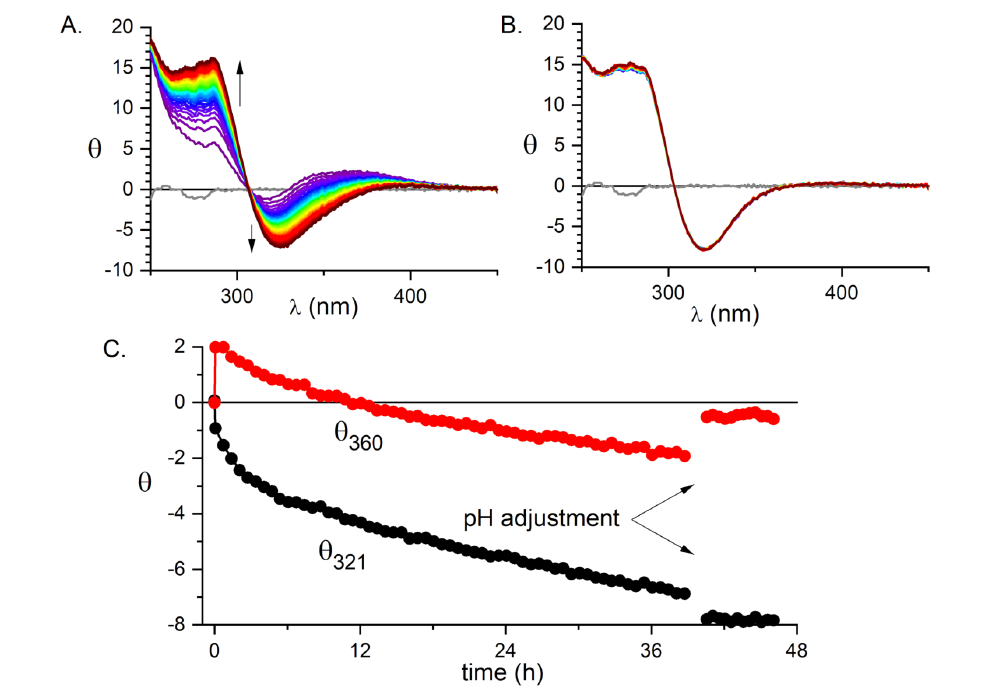
Figure 1. The formation of the 1:1 Pd(II) complex of A β 4 − 16 monitored by CD. ( A ) The 40 h evolution of CD spectra of the sample containing 0.3 mM A β 4 − 16 and 0.255 mM K 2 PdCl 4 at pH 4.0 and room temperature. ( B ) The six-hour evolution of CD spectra of the same sample after the change of pH to 6.5. ( C ) The time dependence of ellipticity at 360 and 321